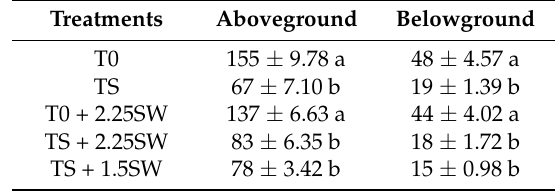
Means with different letters indicate significant differences (Tukey test, p < 0.05).